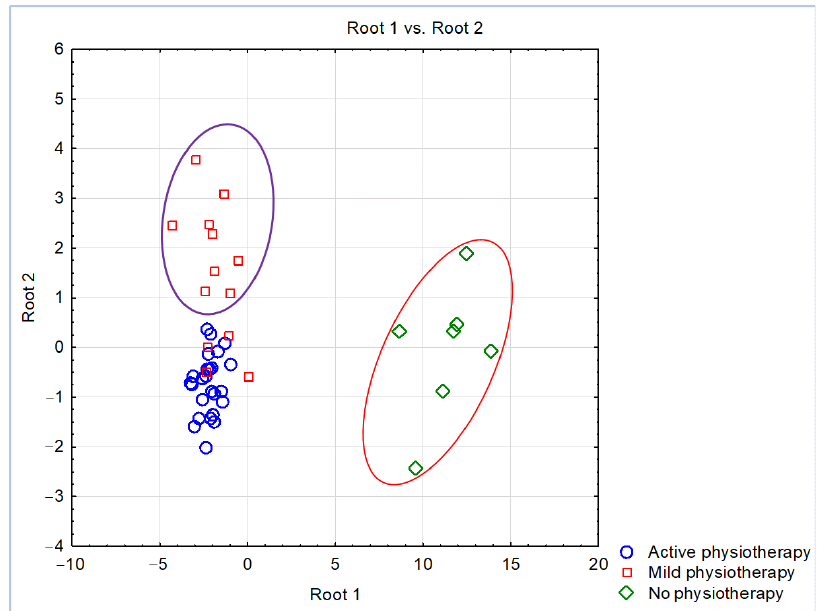
Figure 1. Scatterplot of canonical scores, expressing clinical and biological variables in mild physi- otherapy, active physiotherapy, and no physiotherapy patients.